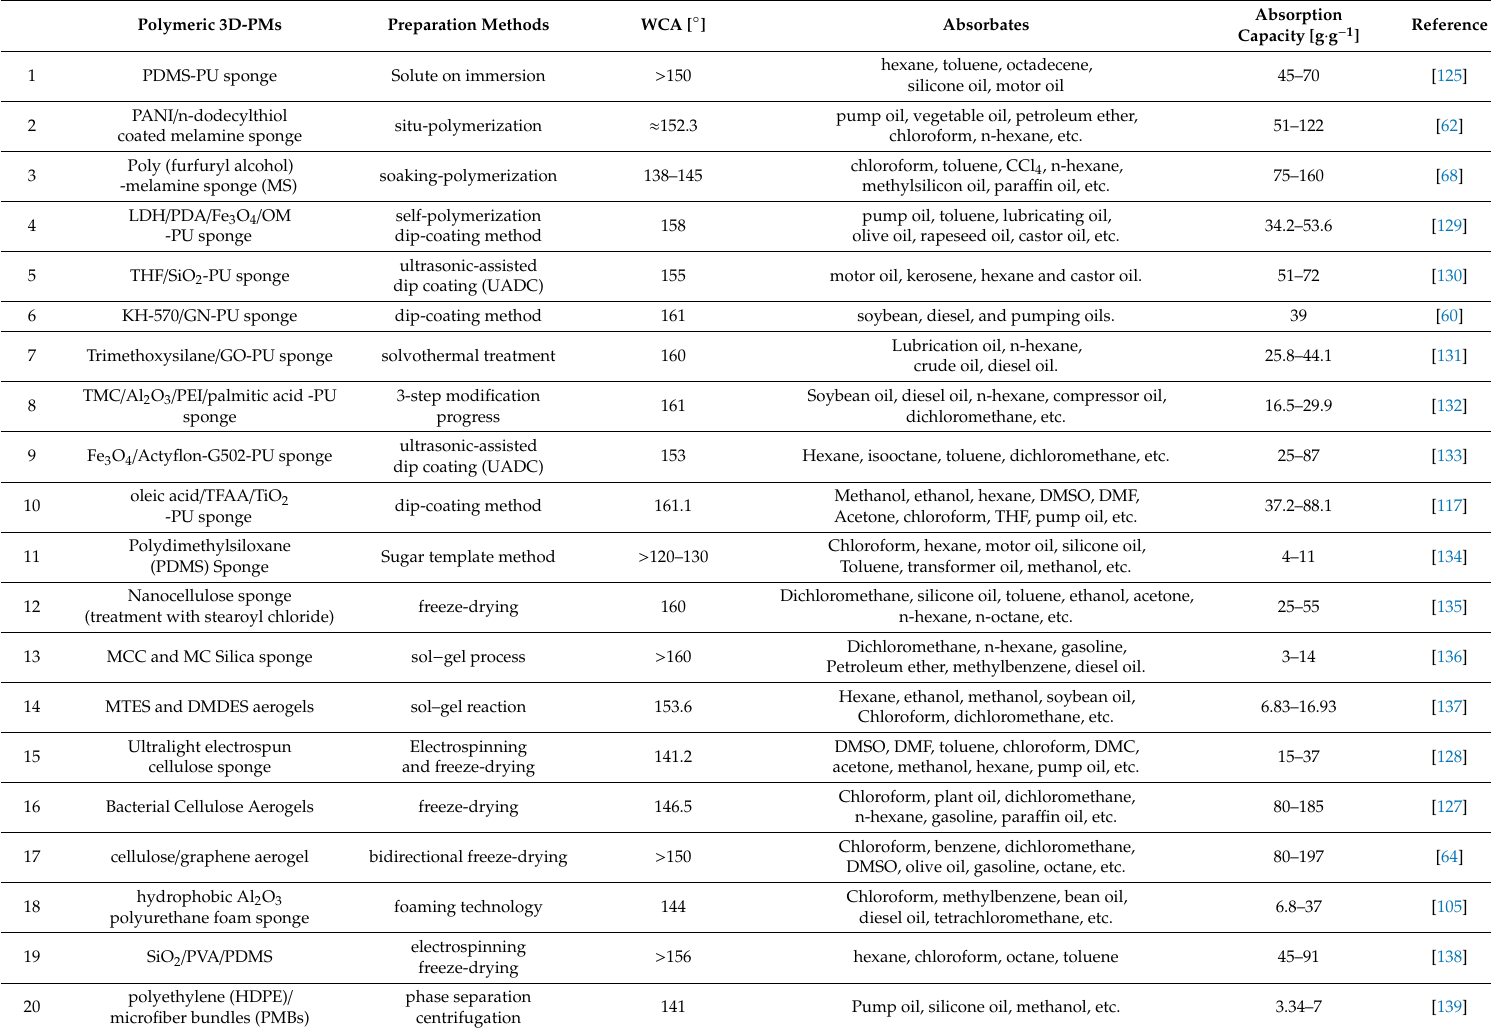
Table 2. Summary and comparison of typical examples of the superhydrophobic-superoleophilic oil / water separation